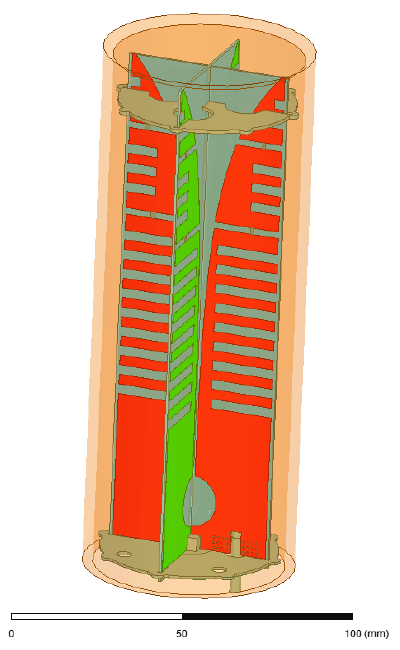
Figure 4. Vivaldi antenna structure diagram.